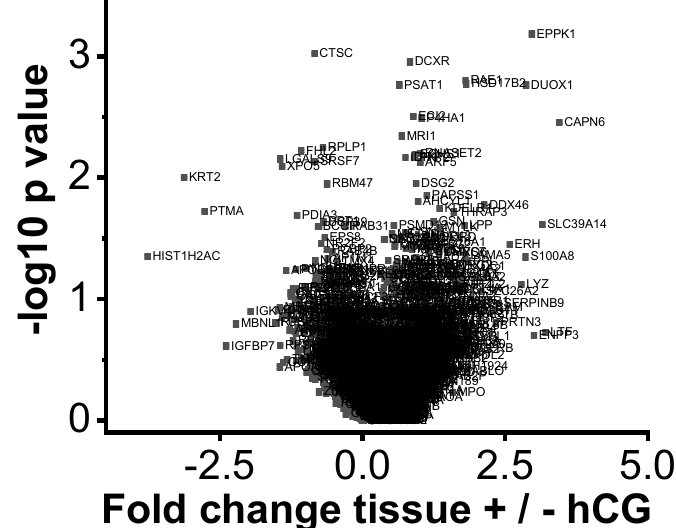
Figure 5. Results of the infusion with 500 IU hCG infusion for 24 h in PF.